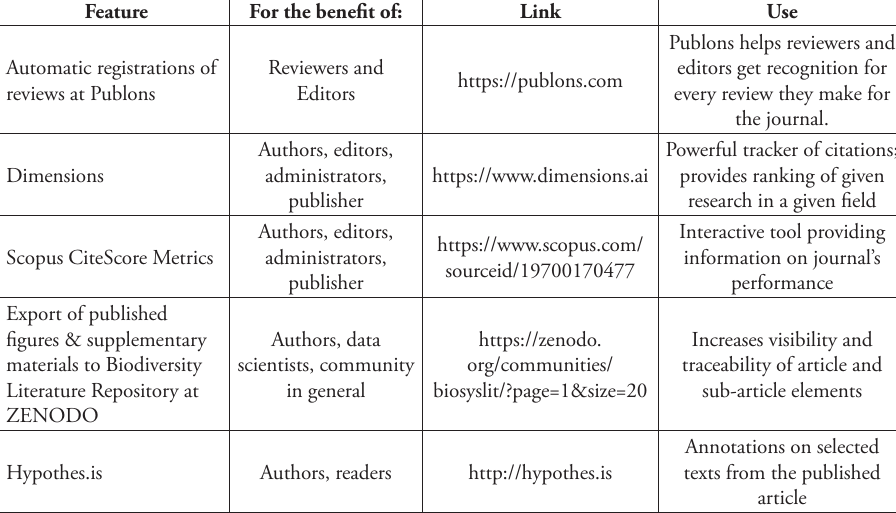
Table 3. New technological solutions implemented in the